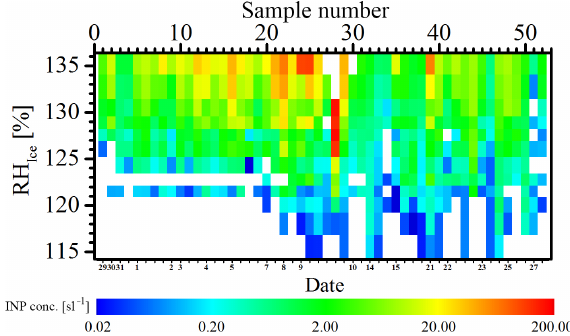
Figure 9. INP concentrations (color-coded) as function of relative humidity with respect to ice in the temperature range from − 20 to − 30 ◦ C (see Table 1) observed during all UAS flights. The date (in days of March (29 to 31) and April (1 to 27)) corresponding to the sample number is given on the lower abscissa. Where no number appears, the date is the same as for the previous